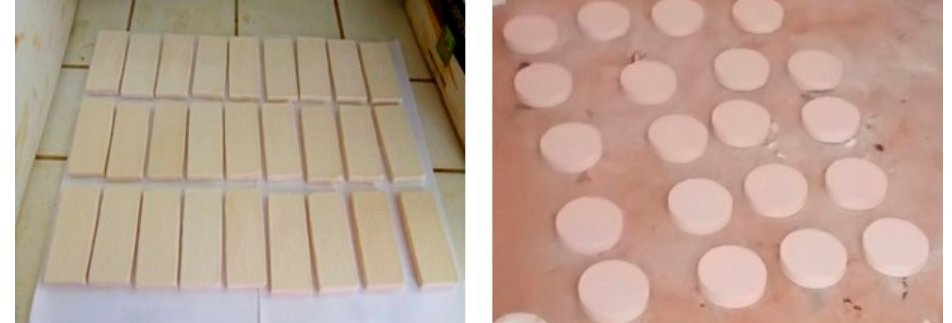
Figure 3. FTIR spectra of kaolin ( a ), bentonite ( b ) and limestone ( c ).